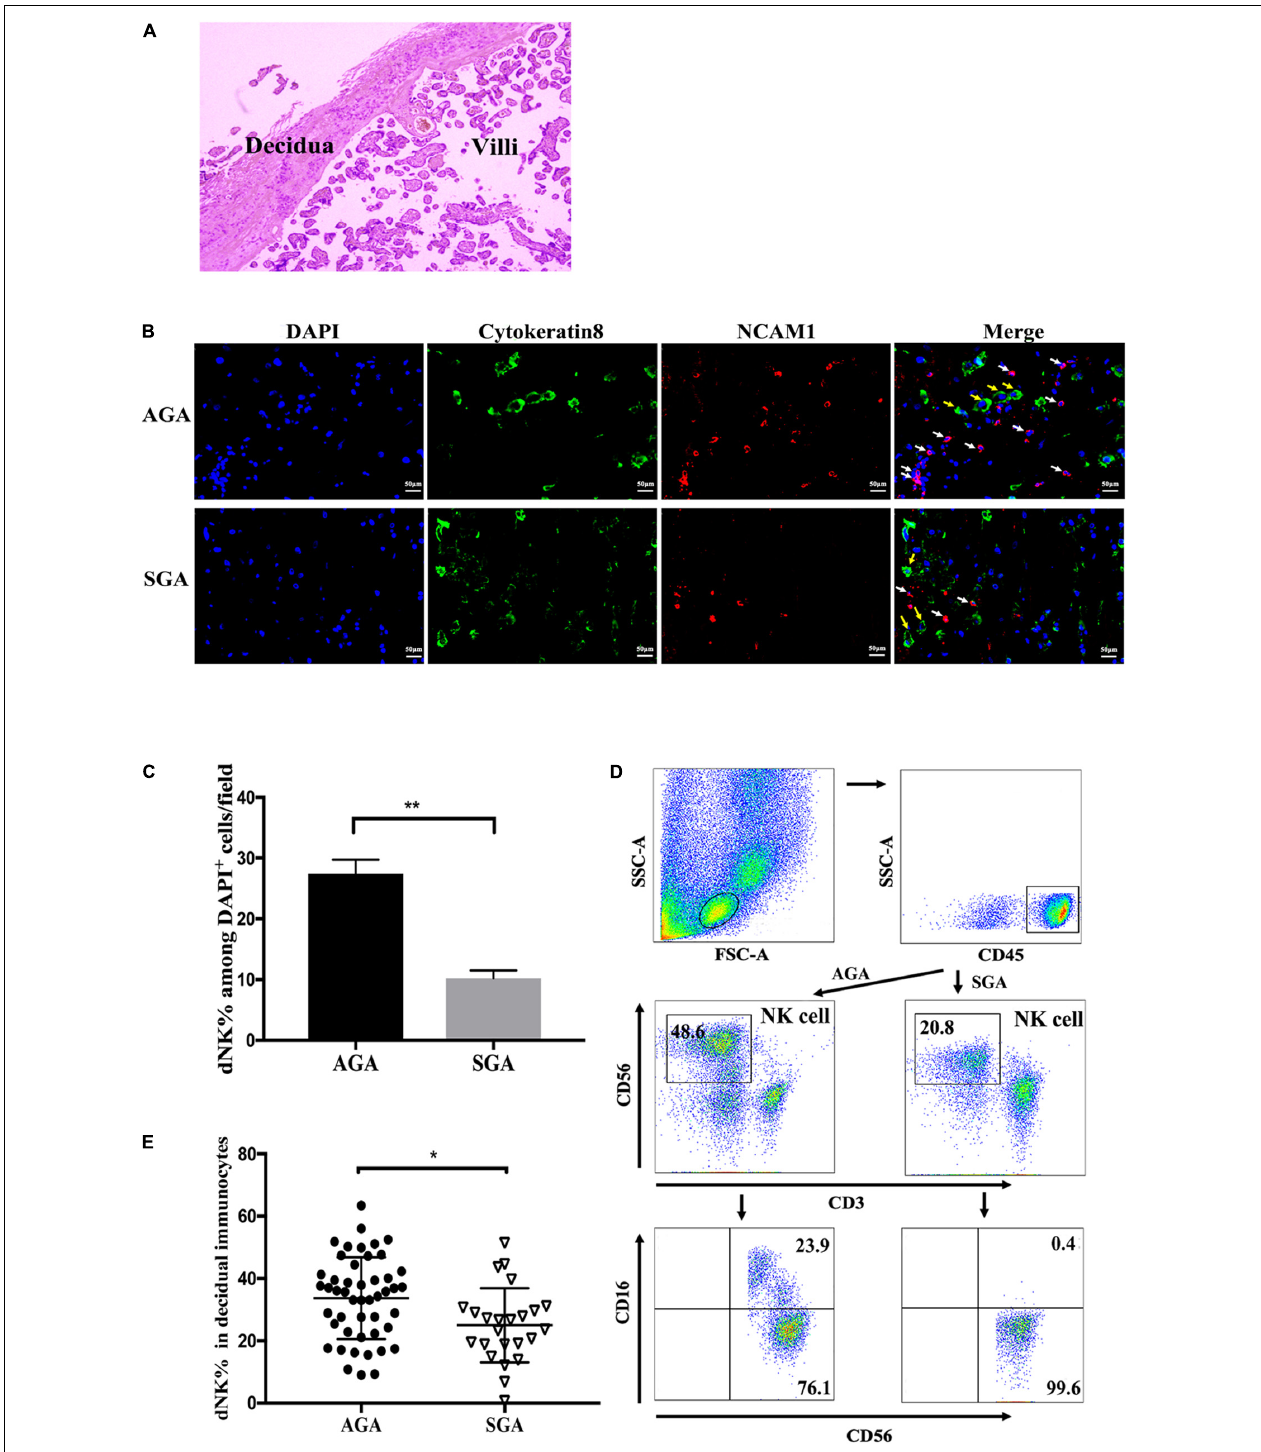
FIGURE 1 | Distribution and phenotypes of dNK cells at the maternal-fetal interface. Paraffin sections of AGA and SGA decidua were stained with NCAM1 (NK cells, red), Cytokeratin 8 (trophoblasts, green), and DAPI (nucleus, blue), and visualized by an inverted fluorescence microscope. (A) The location of decidua and villi in the placenta were demonstrated by HE staining. (B) The distribution of dNK cells (white arrow) and EVT cells (yellow arrow) in AGA and SGA decidua, as shown by immunofluorescence assay. Scale bars represent 50 µ m. (C) Percentage of NK cells in all DAPI + nuclei in AGA and SGA decidual tissues in each field, as quantified by ImageJ ( n = 3). ** p < 0.005. (D) Representative flow cytometry analysis of the expression of CD3 - CD56 + decidual NK cells (in the box above) on gated CD45 + leukocytes. (E) The frequency of dNK cells in SGA ( n = 24) and AGA ( n = 48). * p < 0.05.